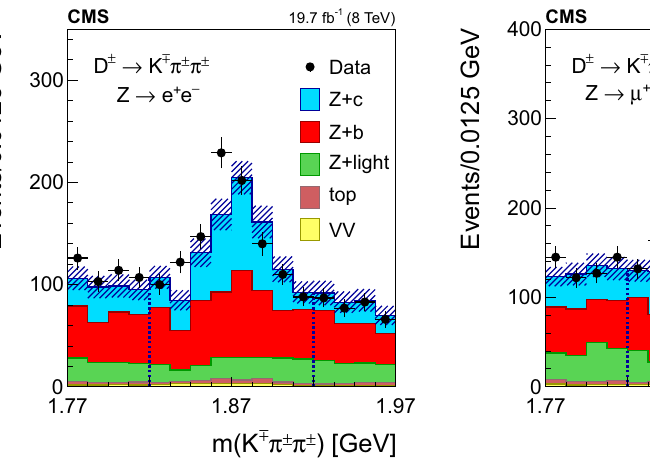
with the simulated samples. The two dashed, vertical lines indicate the mass range of the signal region. Vertical bars on data points represent the statistical uncertainty in the data. The hatched areas represent the statistical uncertainty in the MC